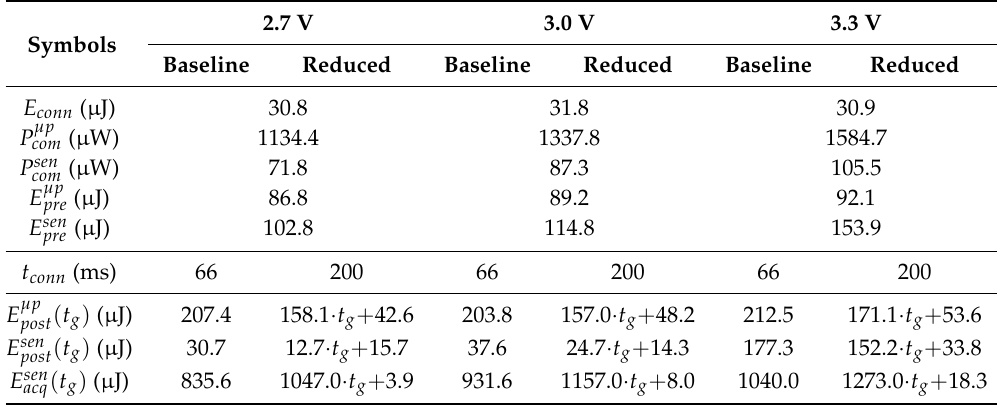
Table 2. The energy model parameters for different energy storage voltages.